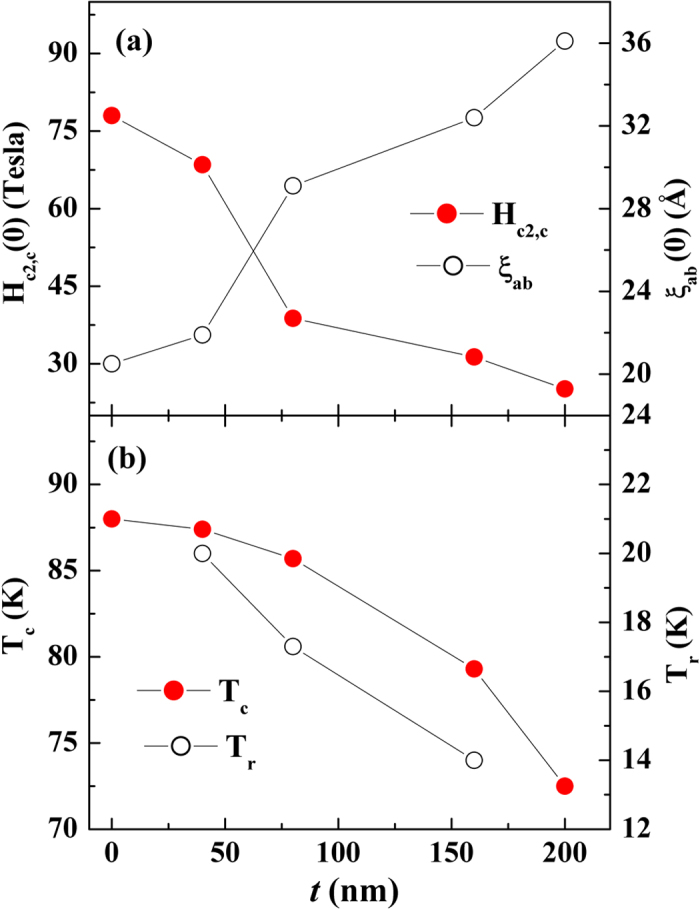
(a) Variations of Hc2,c(0) and ξab(0) with t. (b) Variations of Tc and Tr as functions of t.